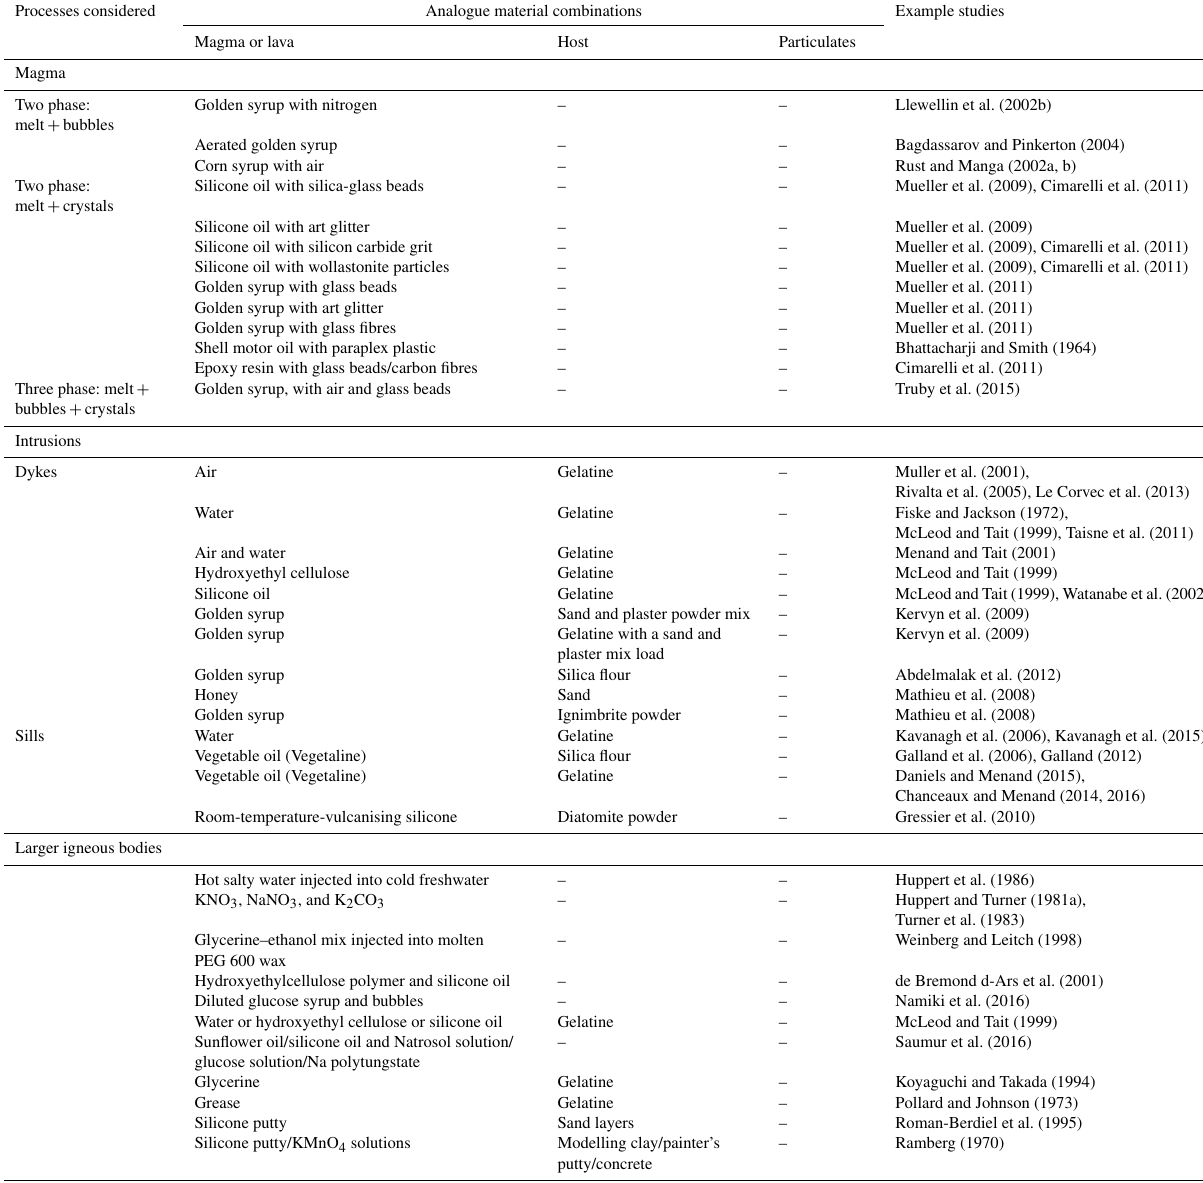
Table 2. Examples of different analogue materials and their combinations used to model different parts of the volcanic and magmatic system. Processes